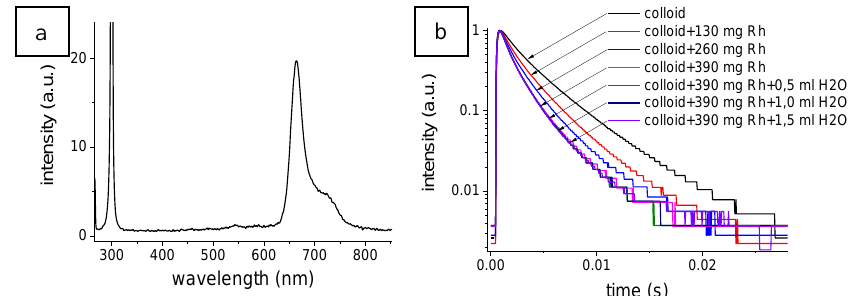
Fig. 3. (a) Luminescence spectrum of the Y 0,4 Ce 0,5 Tb 0,1 F 3 colloid with Radachlorin (b) Luminescence decay curves of the Y 0,4 Ce 0,5 Tb 0,1 F 3 colloid with various concentrations of Radachlorin. Radachlorin was added to the CeF 3 -Y 0.9 Tb 0.1 F 3 nanoparticles in a stepwise manner and